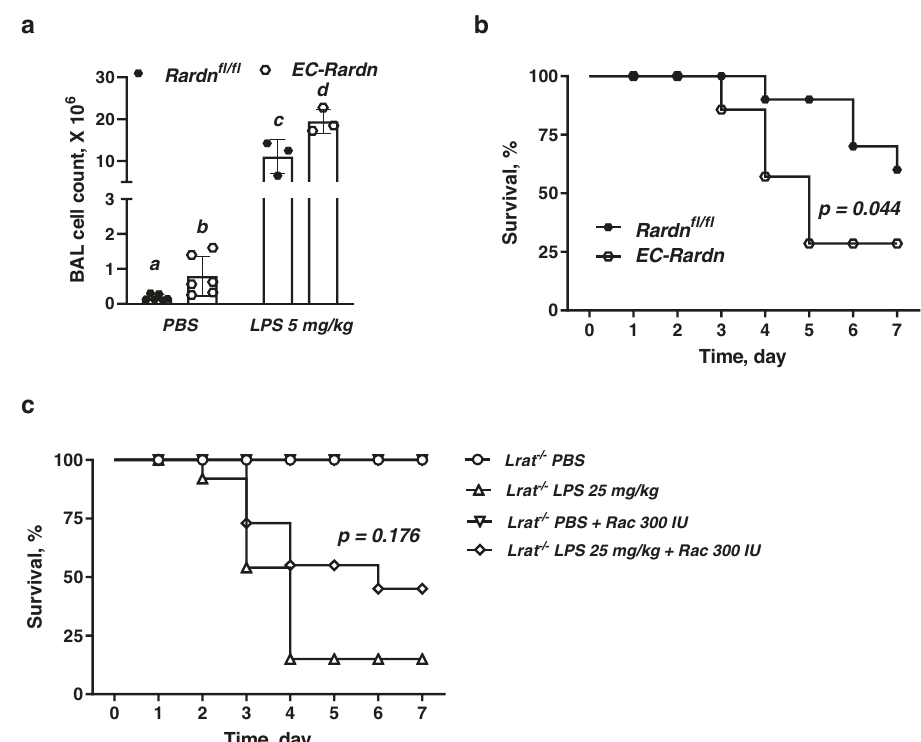
Fig.7|Loss-andgain-of-functionmousemodelsforlungcellretinoidsignaling during LPS-inducedALI. a Bronchoalveolarlavage (BAL) fl uid cellnumbersin EC- Rardn mice24h afterintranasalinstillation of LPS (5mg/kg of body weightin PBS) or PBS alone. Values marked with different letters (a, b, c, d) are statistically dif- ferent (a is different from b, p =0.026; c is different from d, p =0.043). Statistical differences were analyzed by a one-way ANOVA. All values are given as the mean±1S.D., n =6 for PBS group, n =3 for LPS group. b Kaplan – Meier survival curvesforEC-Rardnmiceaswellasfortheirrespectivelittermatecontrols( Rardn fl / fl mice) over the 7-day period after intranasal instillation of a LPS (25mg/kg of body